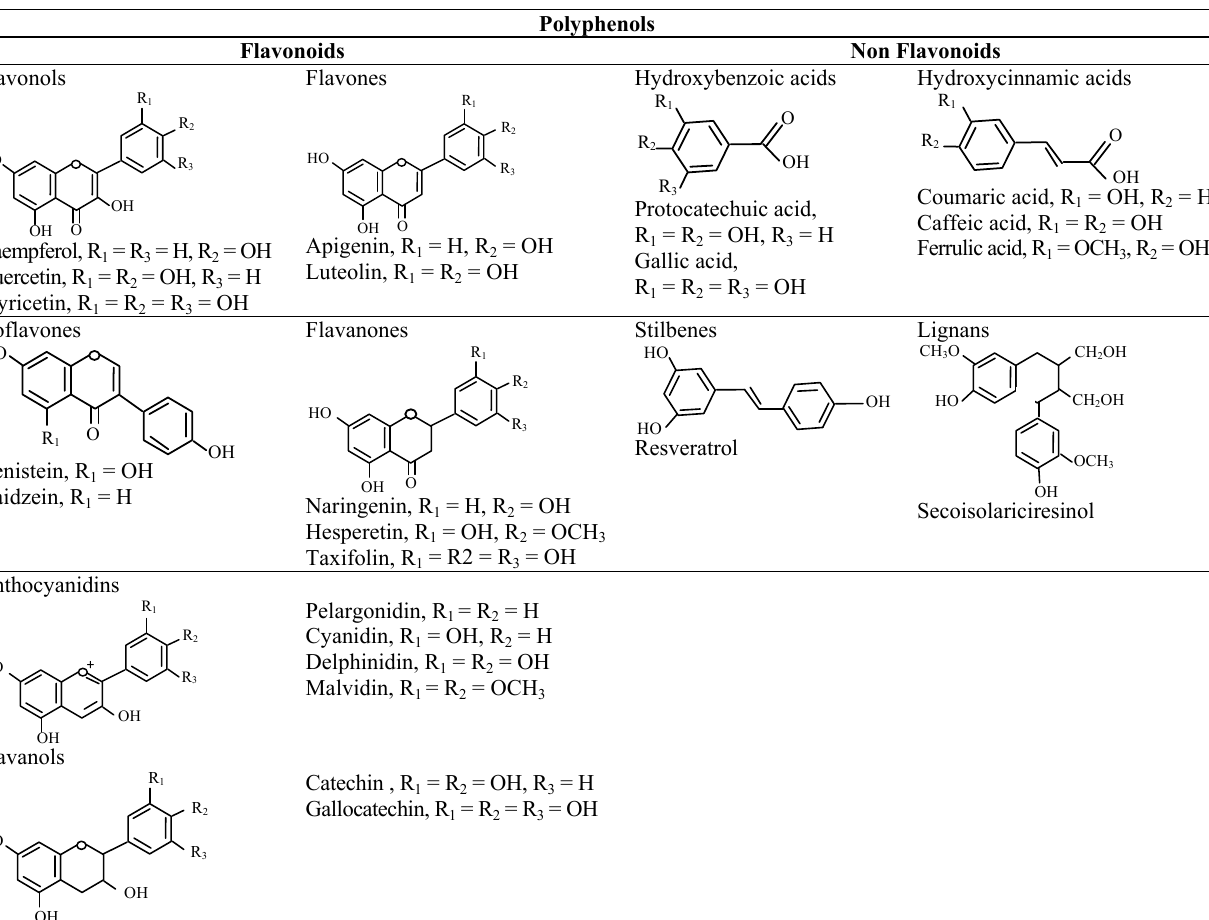
Figure 2. Chemical structures of polyphenols. Modified from Vauzour